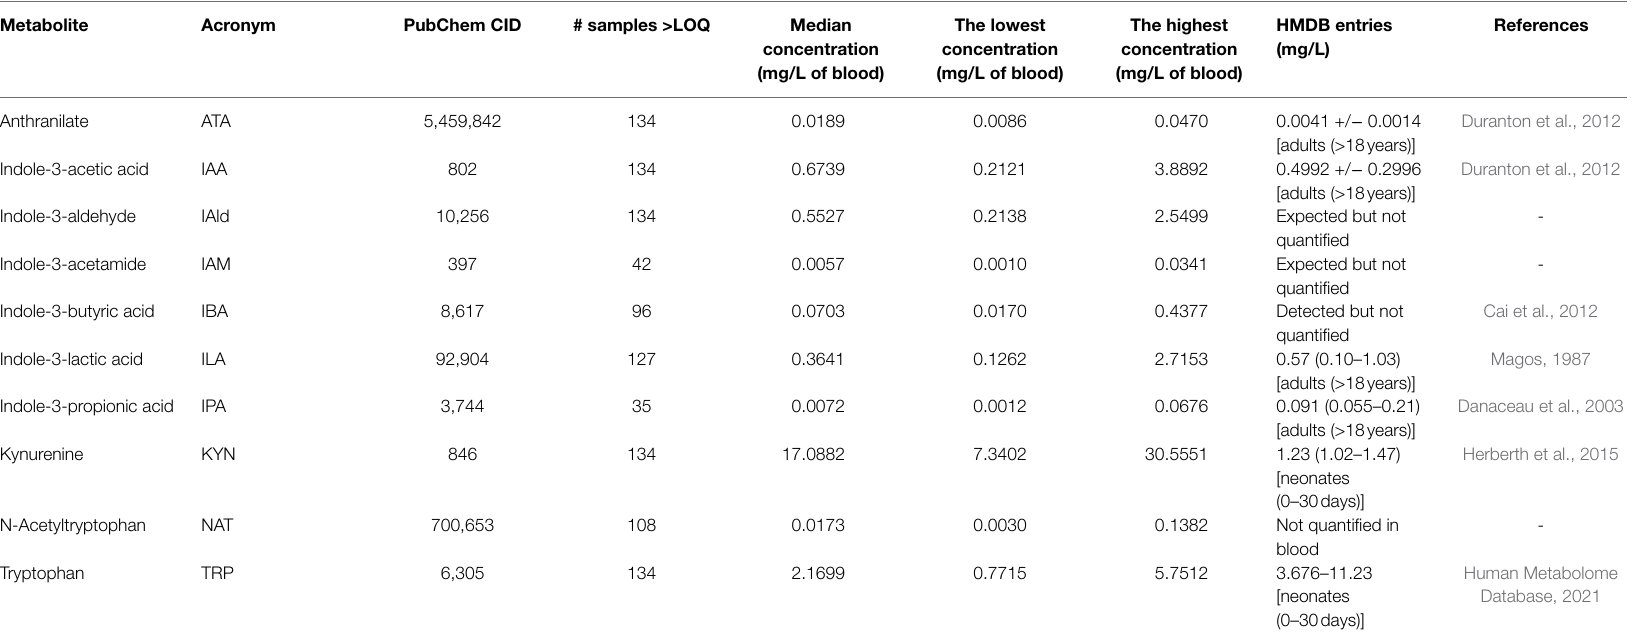
TABLE 1 | The lowest, the highest, and median concentrations of tryptophan and kynurenine catabolites in DBS. Metabolite Acronym PubChem CID # samples >LOQ Median